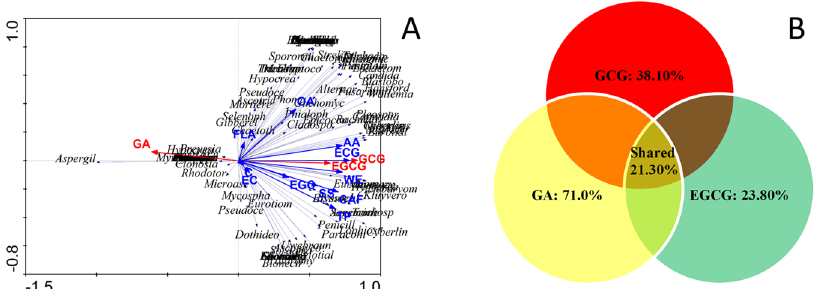
Figure 4. RDA and VPA showing the correlations between fungal structure and metabolites concentrations during manufacturing process of Fu brick tea. Ordination diagram of RDA ( A ). Variance decomposition of VPA ( B ). Gallic acid (GA), epigallocatechin gallate (EGCG), gallocatechin gallate (GCG). Red arrow indicated the metabolite variance significant effect on the fungal community structure (P <